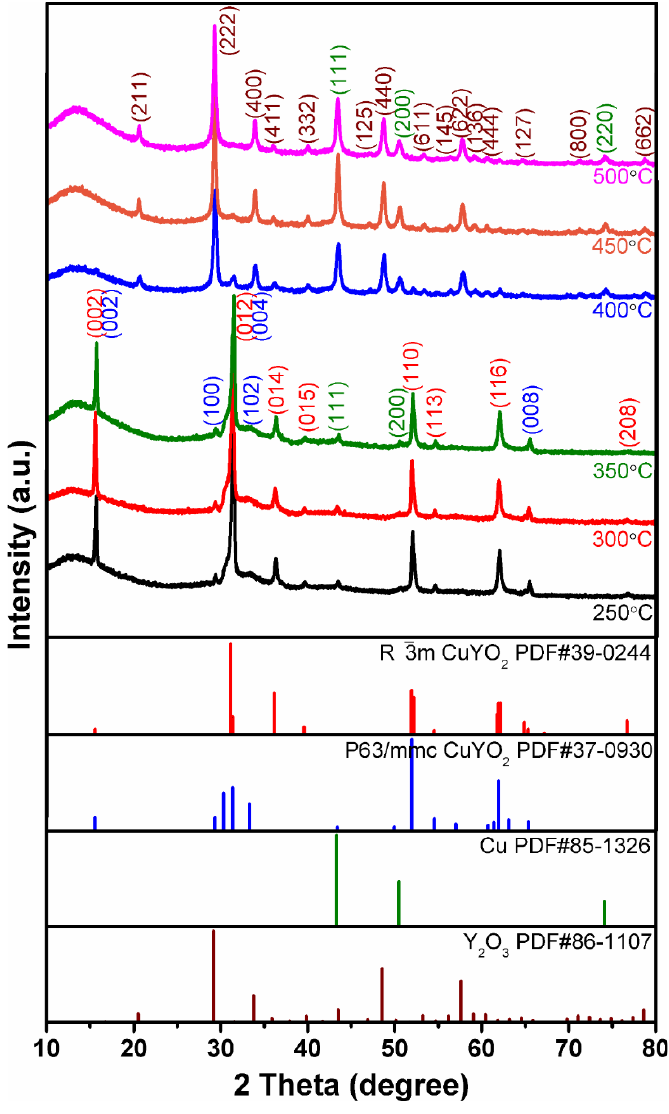
Figure 12. XRD pattern of CuYO 2 nanofibers after MSR at different temperatures.